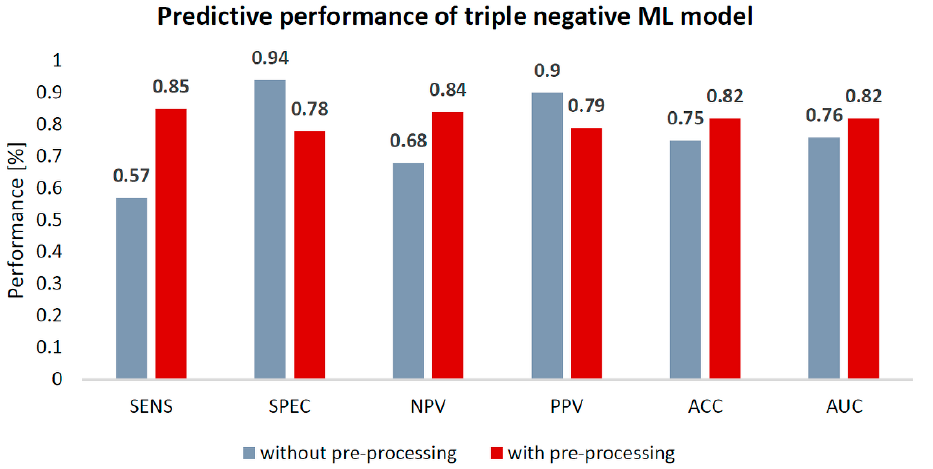
Figure 4. Performance comparison of triple negative subtype machine learning (ML) predictive models, with and without data pre-processing. ACC = Accuracy; SENS = Sensitivity; SPEC = Specificity; NPV = Negative Predictive Value; PPV = Positive Predictive Value. Performance is expressed in percentages (%).